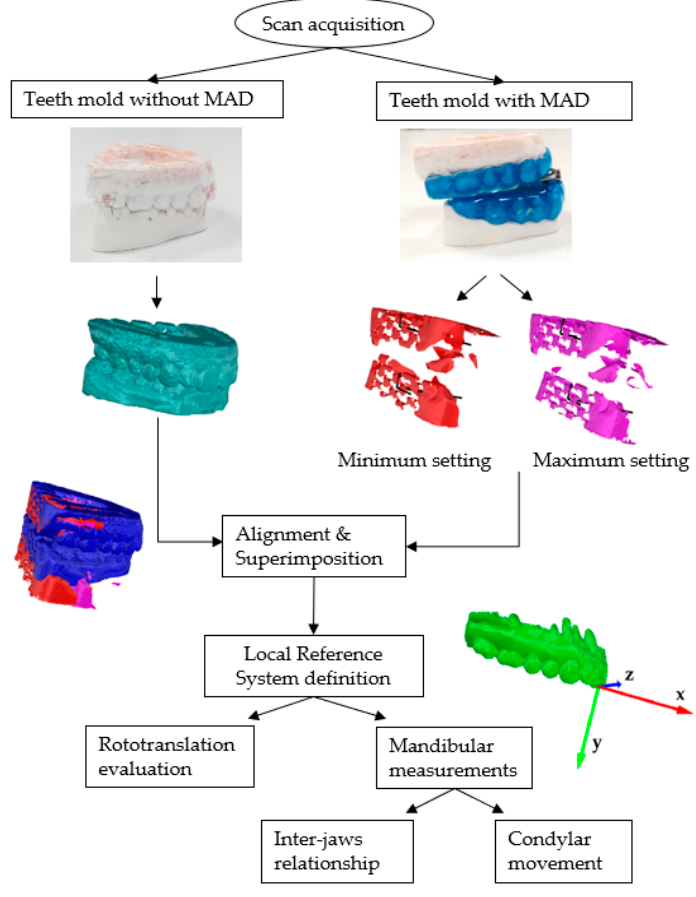
Figure 4. Workflow representing the main steps involved in the assessment of the mandibular kinematics when using a mandibular advancement device (MAD).